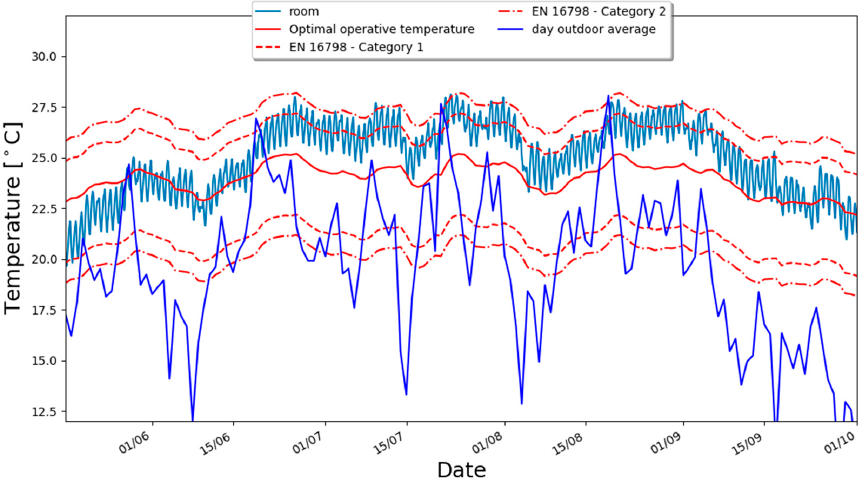
Figure 9. Temperature in the living room during the non-heating season; low-emitting configuration.